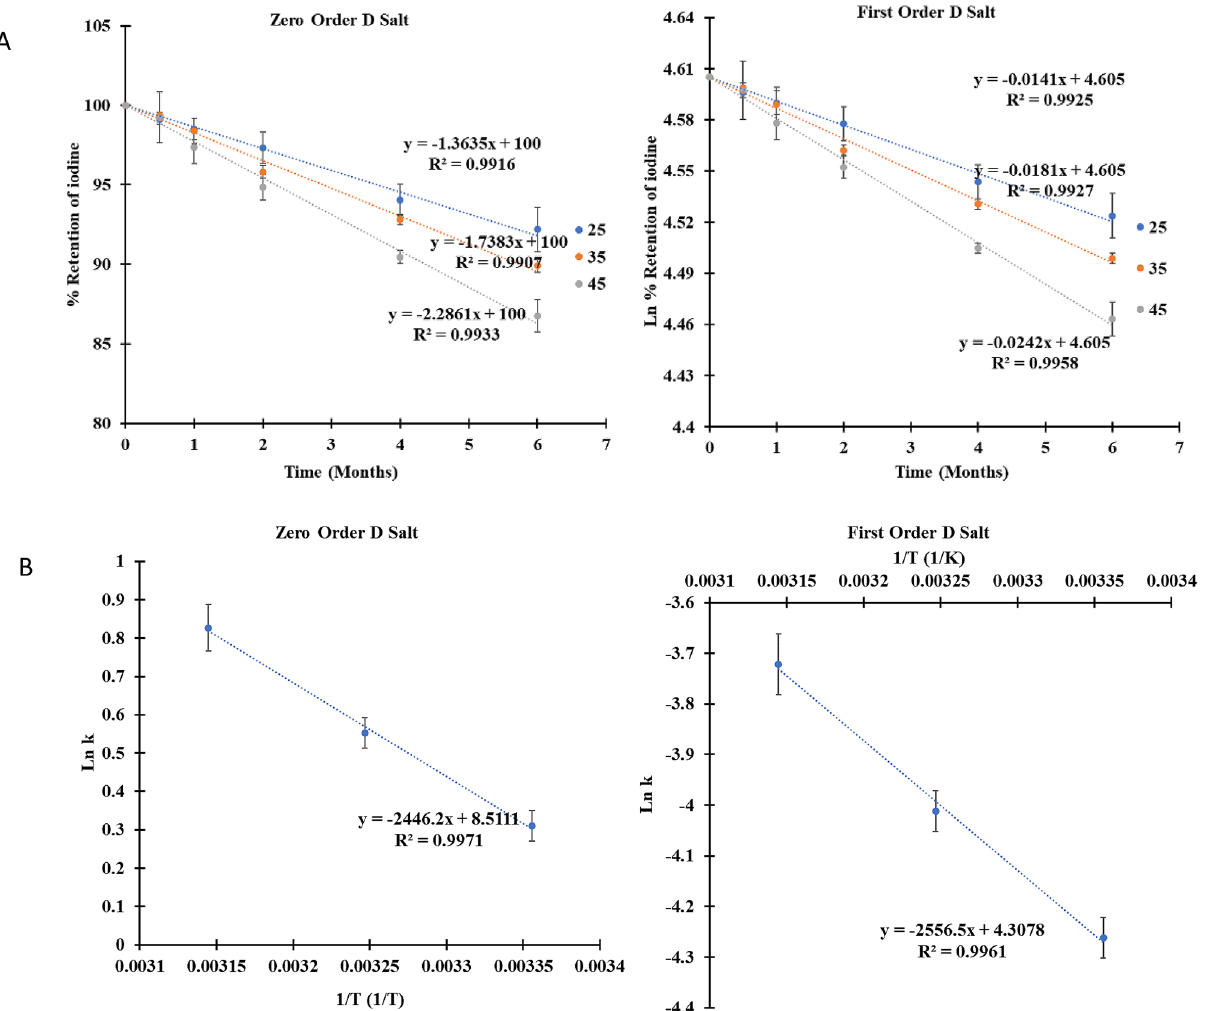
Figure 3. ( A ) Sample of the zero- and first-order degradation kinetics of iodine in a fortified salt; ( B ) Sample of the Arrhenius plot for the zero- and first-order degradation kinetics of iodine in a fortified salt.